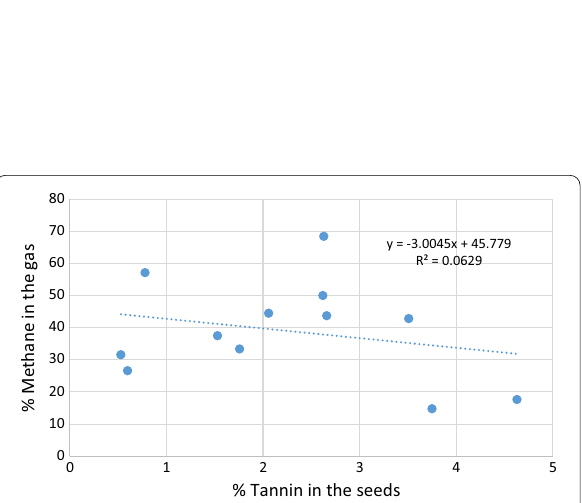
Fig. 2 Relationship between in vitro methane and percentage of tannin in the